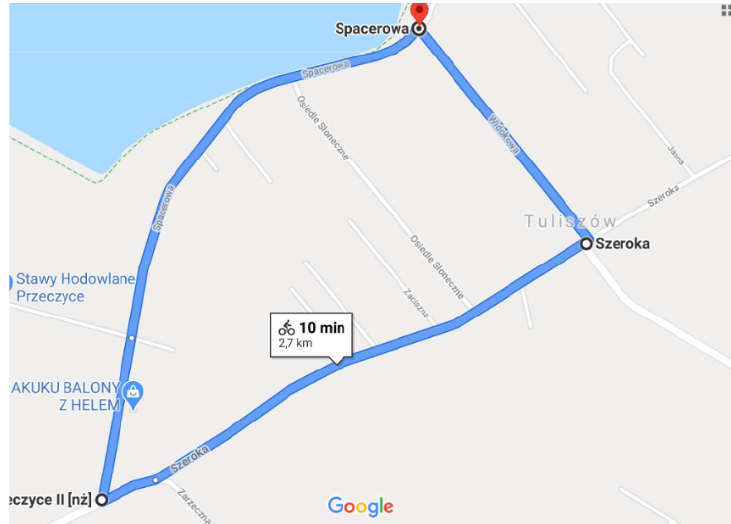
Figure 3. Test route (Google Maps). Table 1. Selected